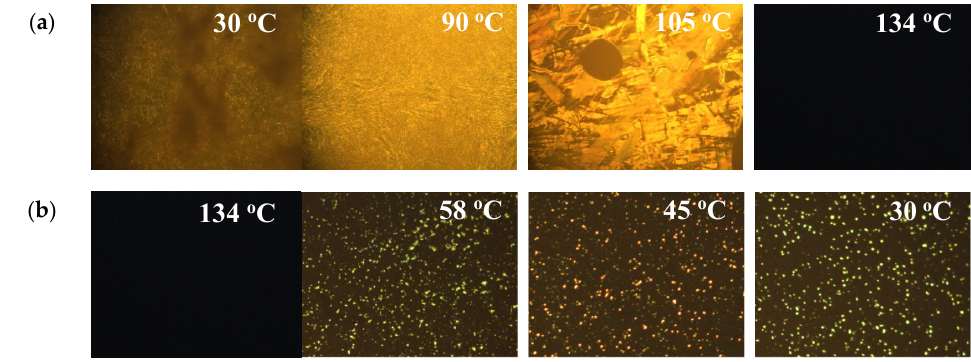
Figure 4. POM of sample 7 during heating ( a ) and cooling ( b ).